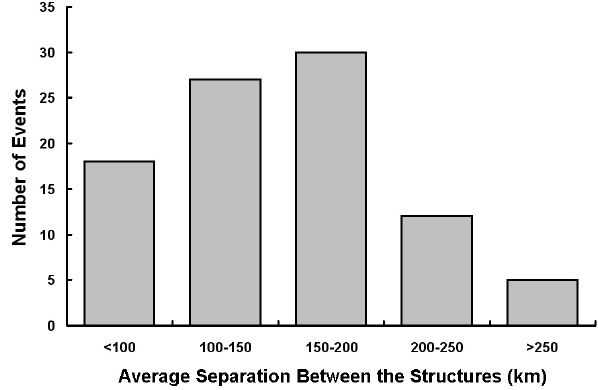
Fig. 10. Histogram plot showing the distribution of the average sep- arations between two consecutive bubble structures observed from Brasilia and